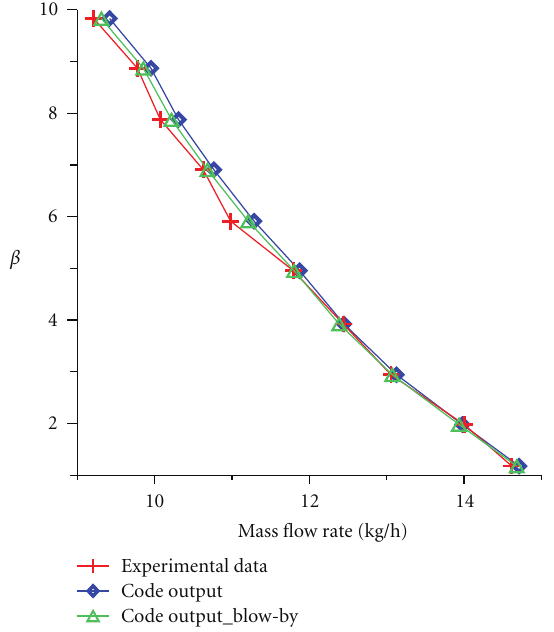
Figure 15: Characteristic curves comparison.